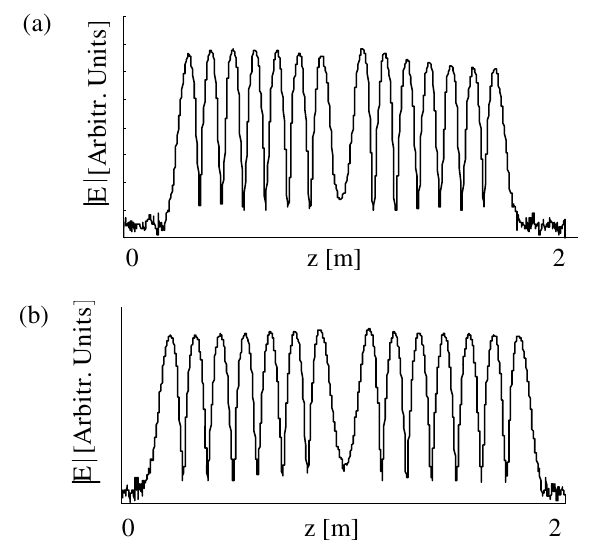
FIG. 3. Peak-to-peak field flatness. (a) P1, 92% and (b) P2,